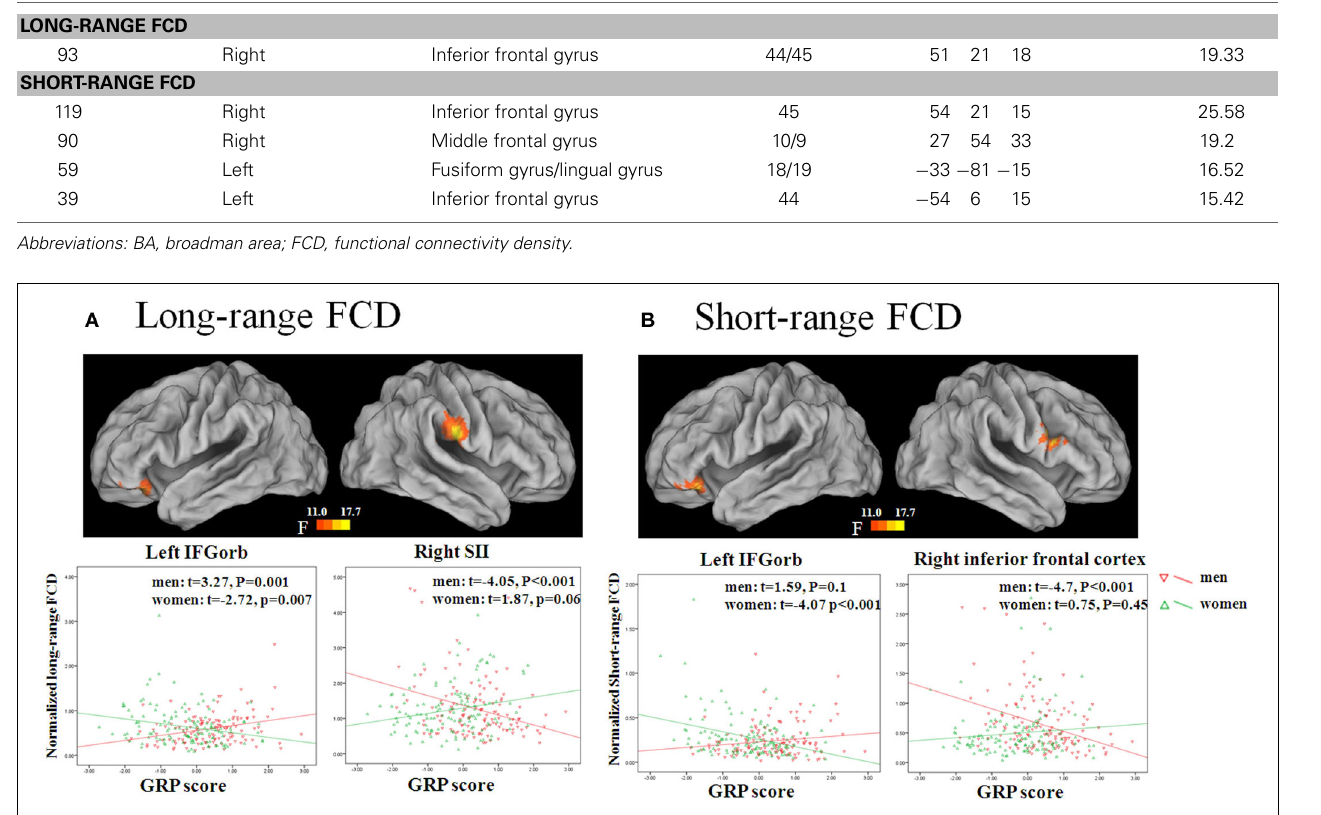
p < 0 . 0001), but not for women ( β = 0 . 03, SE = 0 . 04, t = 0 . 75, p = 0 . 45) ( Figure 2 , Table 3 ) 1 , 2